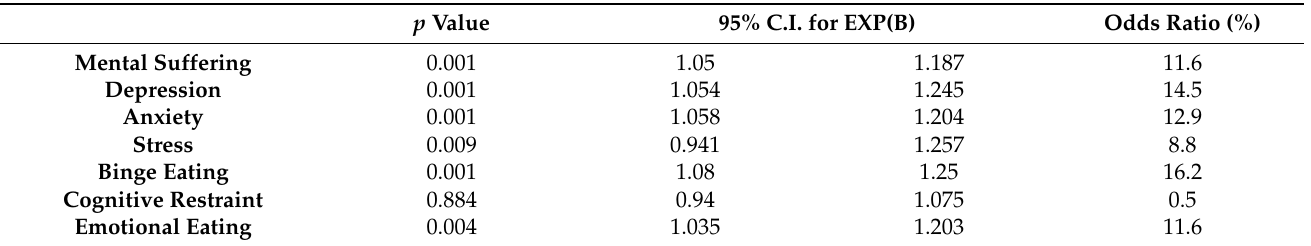
Table 3. Logistic regression regarding body mass index and the presence of mental health and behavioral